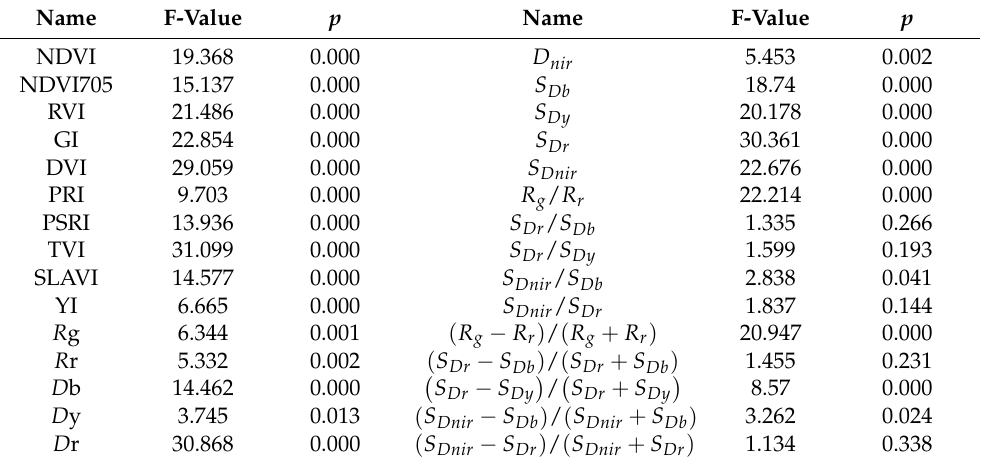
Table 5. Results of variance analysis of vegetation index and hyperspectral characteristic parameters of Pinus yunnanensis canopy with different degrees of